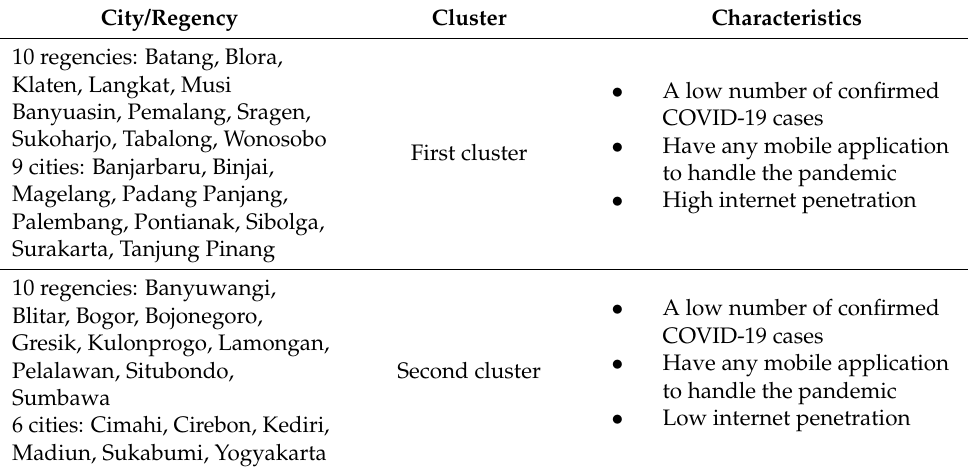
Table 3. Typology of cities and regencies included in the 100 Smart City movement in